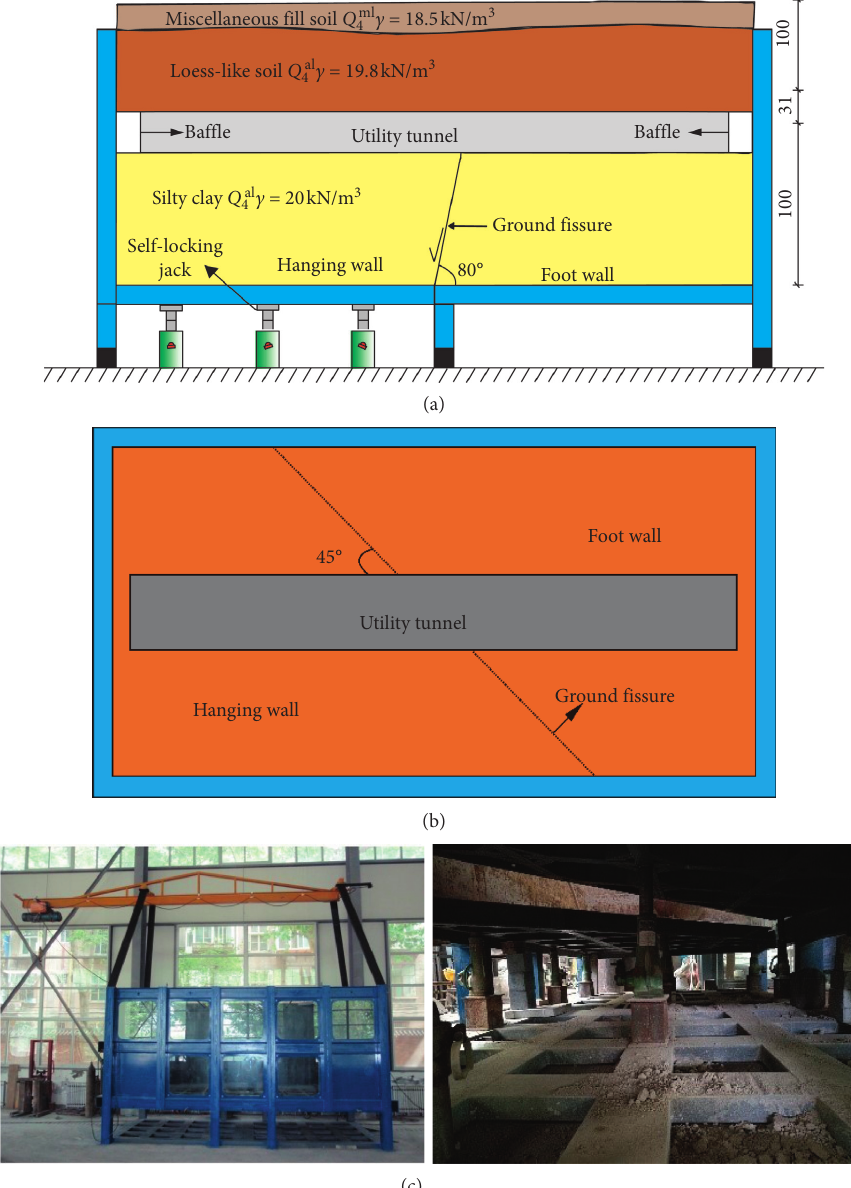
Figure 3: Diagram of ground fissure and utility tunnel (cm). (a) Model of ground fissure and utility tunnel structure (cm). (b) Schematic diagram of oblique crossing of ground fissure and utility tunnel structure. (c) Picture of model box and self-locking